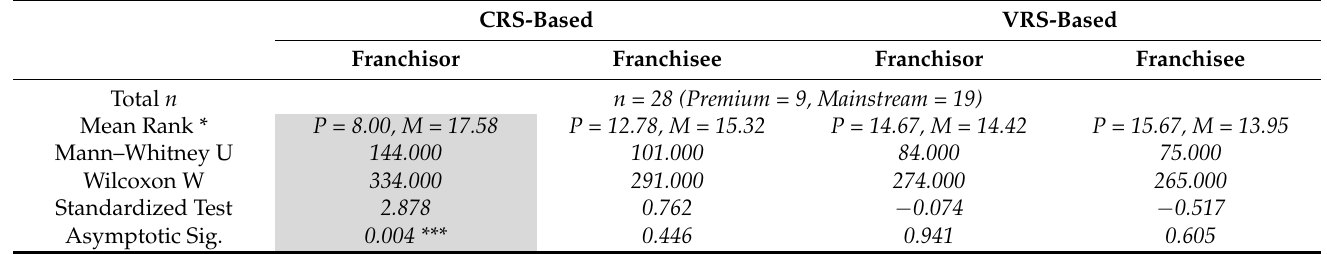
Table 7. Analysis result of Mann – Whitney U test between premium and mainstream coffee chain.